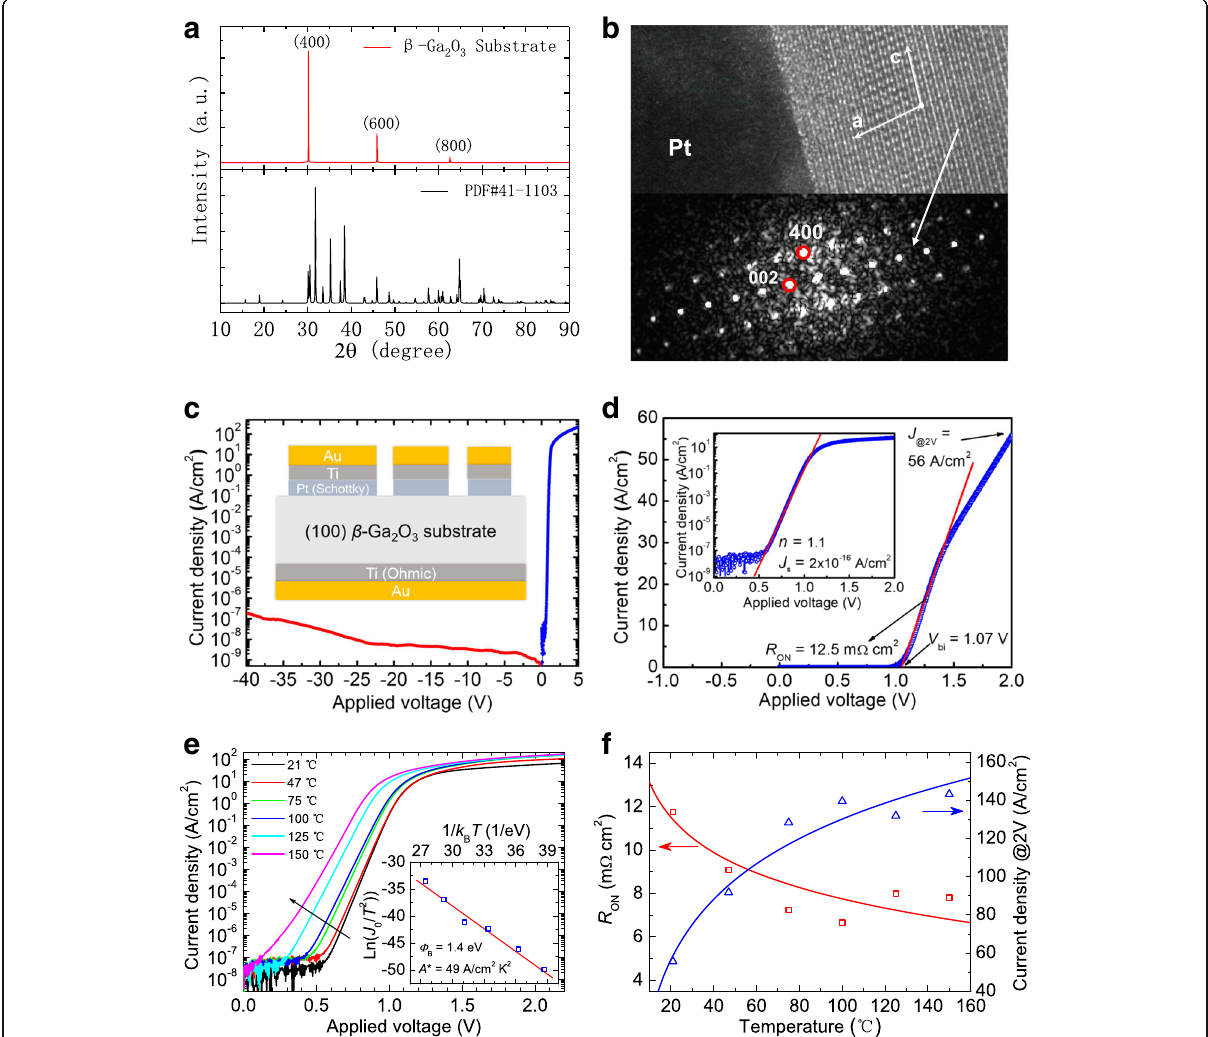
Fig. 6 a X-ray diffraction (XRD) curve of (100) β -Ga 2 O 3 single-crystal substrate, clearly showing the peaks of (400), (600), and (800) planes. b Cross-sectional high-resolution transmission electron microscope (HRTEM) image of Pt/ β -Ga 2 O 3 Schottky contact and fast Fourier transformed (FFT) micrograph of β -Ga 2 O 3 crystal. c Forward and reverse J – V curve of a Pt/ β -Ga 2 O 3 SBD and the schematic of the SBD (inset). d Forward J – V curve in linear and semi-logarithmic plot. e Temperature-dependent J – V curves and the Richardson ’ s plot (inset). f Dependence of ON-resistance and forward current density on temperature. Reprinted from ref.